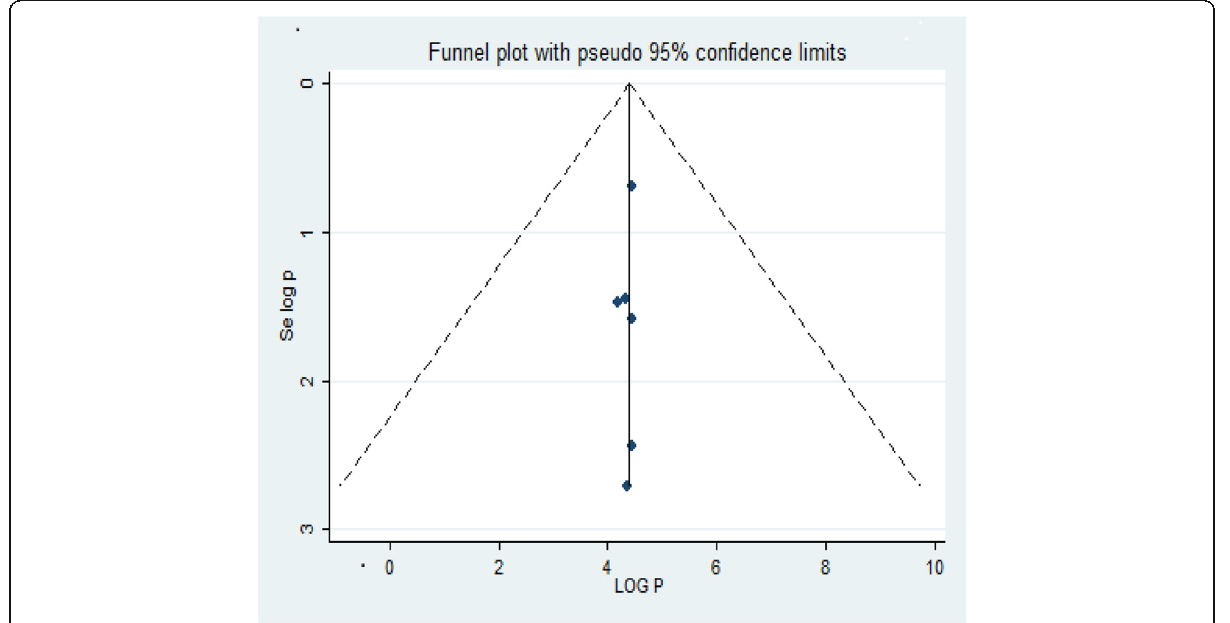
Fig. 2 Funnel plot of successful treatment outcome with 95%